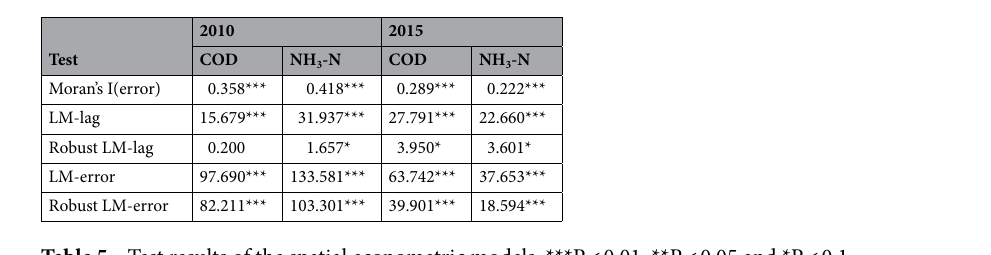
Table 5. Test results of the spatial econometric models. ***P < 0.01, **P < 0.05 and *P <